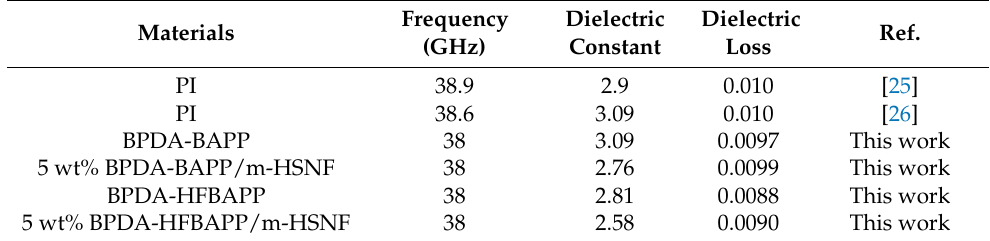
Table 5. Comparison of PI and PI/m-HSNF developed here and the other sensors reported